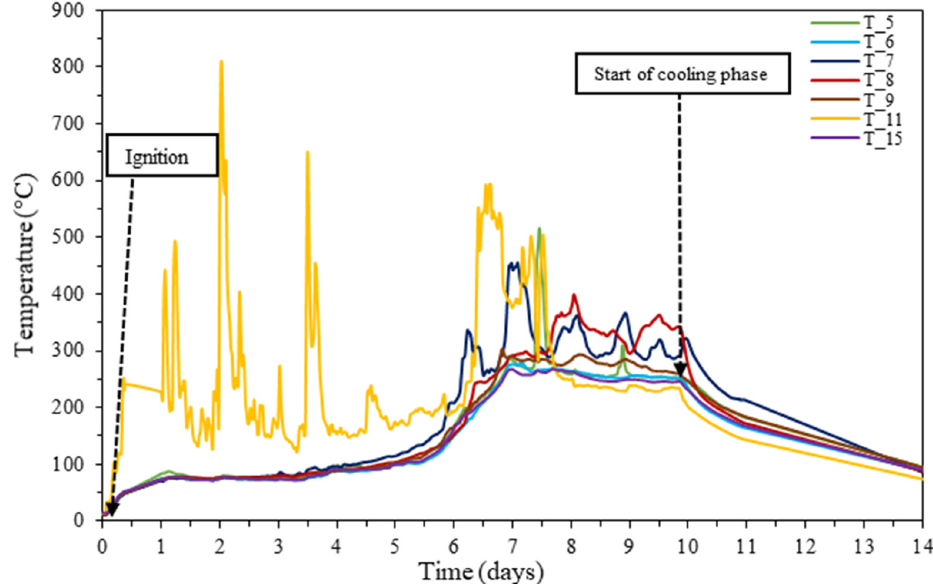
Figure 2. Temperature–time profiles at level 0.8 m of the kiln during the first 14 days of Test 1. T5–T9, T11, and T15 according to Figure 1.